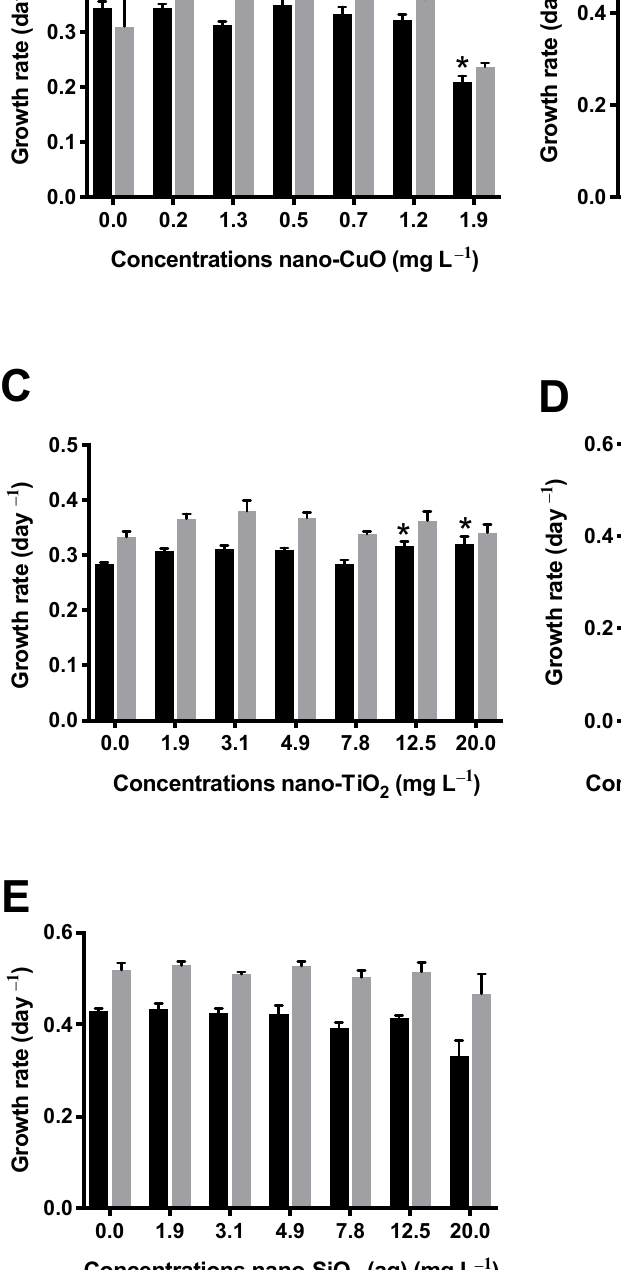
Figure 2. Average growth rate (day − 1 ) regarding the frond number (black bars) and dry weight of fronds (grey bars) of L. minor exposed to the different concentrations of nano-CuO ( A ), nano-ZnO ( B ), nano-TiO 2 ( C ), hydrophilic nano-SiO 2 ( D ), nano-SiO 2 (aq) ( E ) for 7 days. The experiments were conducted in triplicate and the results are shown as the mean ± standard deviation (ANOVA followed by Dunnett ´ s test, * p < 0.05 compared to control). For nano-TiO 2 stabilized by HNO 3 , no growth inhibition was detected when L. minor plants were exposed even at the highest tested concentrations (Figure 2C). In fact, there was a slight stimulation at the highest concentrations regarding the frond number ( p <